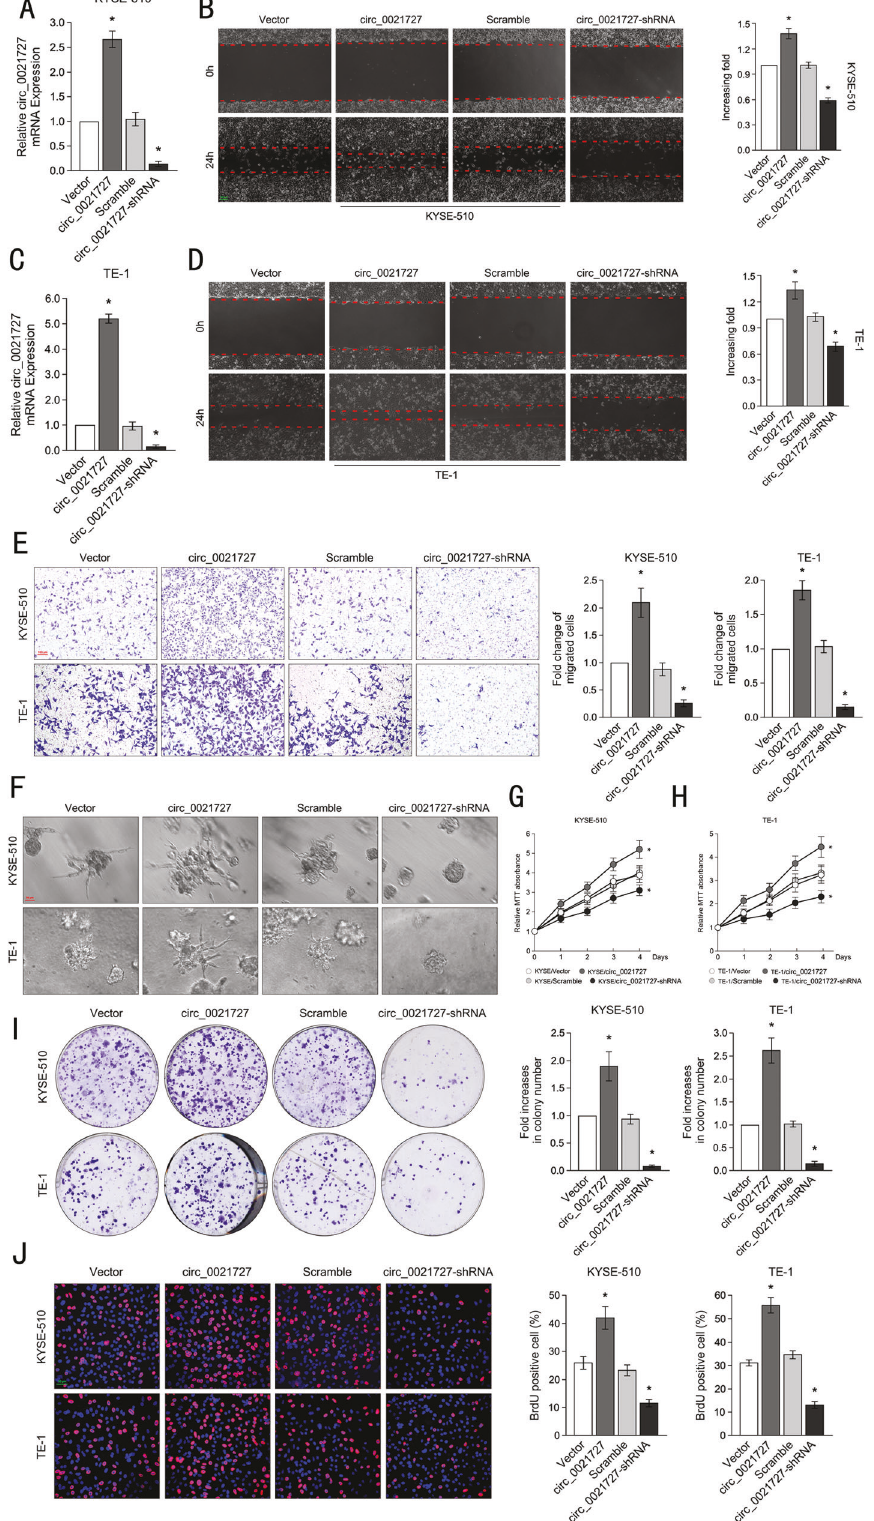
sacri fi ced the mice and examined the formation of metastatic than the mice injected with hsa_circ_0021727 knockdown cells